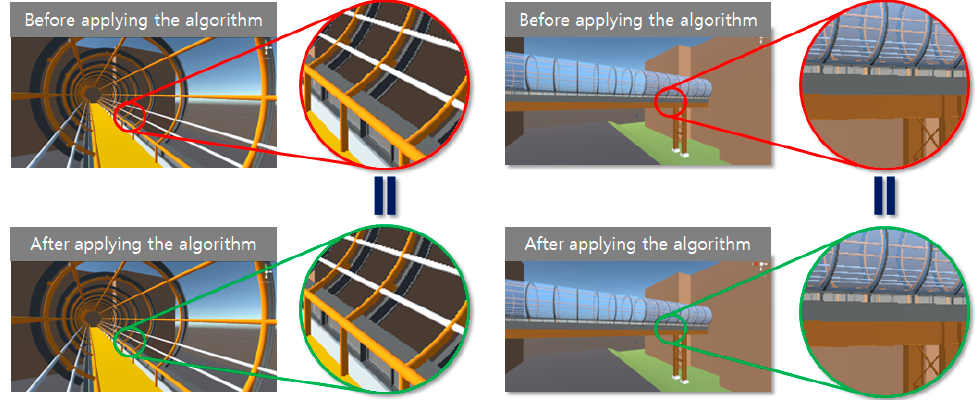
Figure 10. No. 2 SKKU engineering building in 3D engine before and after applying algorithm. Figure 11. Optimized model visualization with AR device.